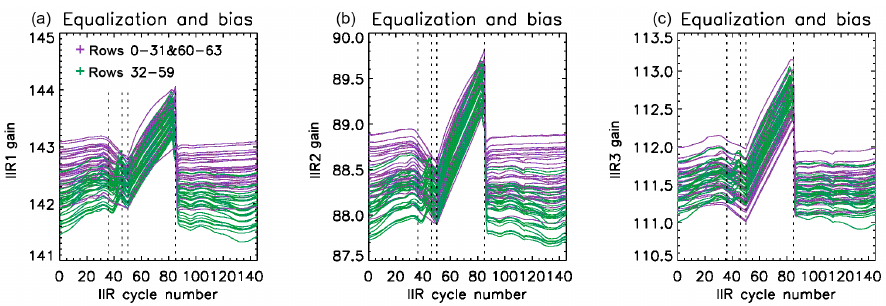
Figure 9. Mean gains vs. IIR cycle number in June 2012 for each of the 64 rows in IIR1 (a) , IIR2 (b) , and IIR3 (c) after equalization and bias corrections. Purple: sound rows; green: flawed